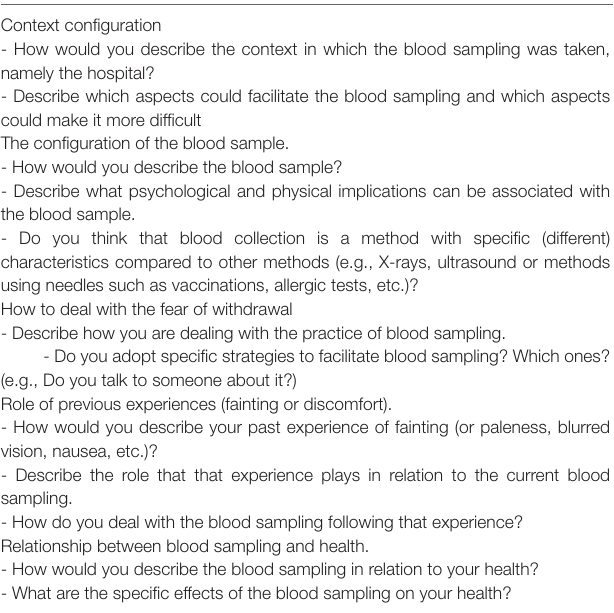
TABLE 1 | Summary of topic and